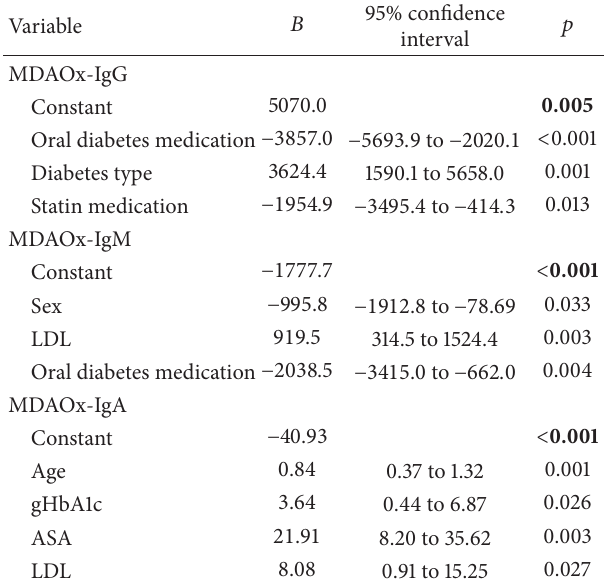
Table 4: Multiple linear regression for autoantibody levels. The variables included in the model were sex, age, BMI, diabetes duration and type, gHbA1c, LDL, and medications. Negative values indicate inverse effect and for sex, female sex has decreasing